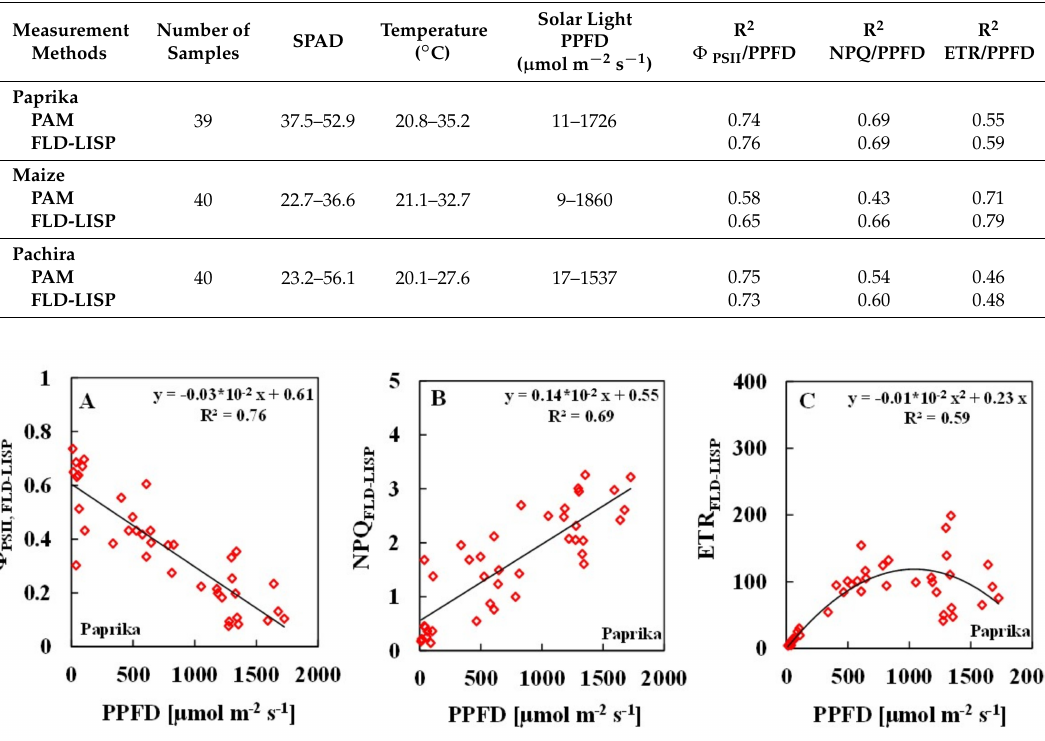
Figure 4. Relationships between solar PPFD and ChlF parameters ( A ) Φ PSII ; ( B ) NPQ; and ( C ) ETR of paprika leaves estimated by the FLD-LISP method. The results of the PAM method were very similar and the details are given in Table 1.